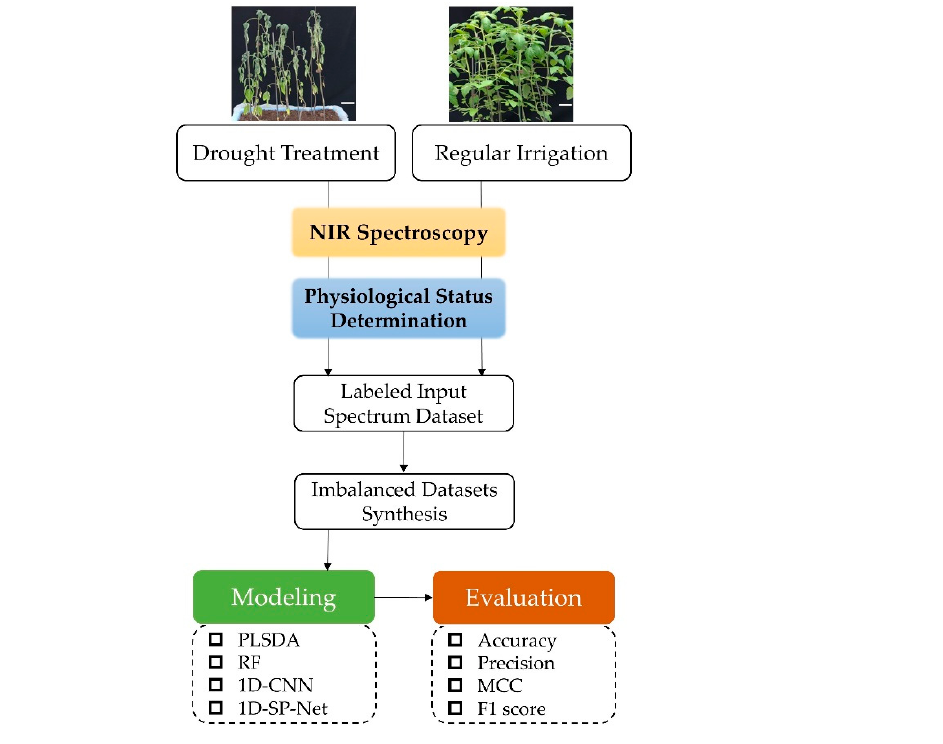
Figure 1. General workflow in this study. NIR, near infrared; PLSDA, partial least squares discriminant analysis; RF, random forest; 1D-CNN, one-dimensional convolutional neural network; 1D-SP-Net, one-dimensional spectrogram power net; MCC, Matthew’s correlation coefficient.